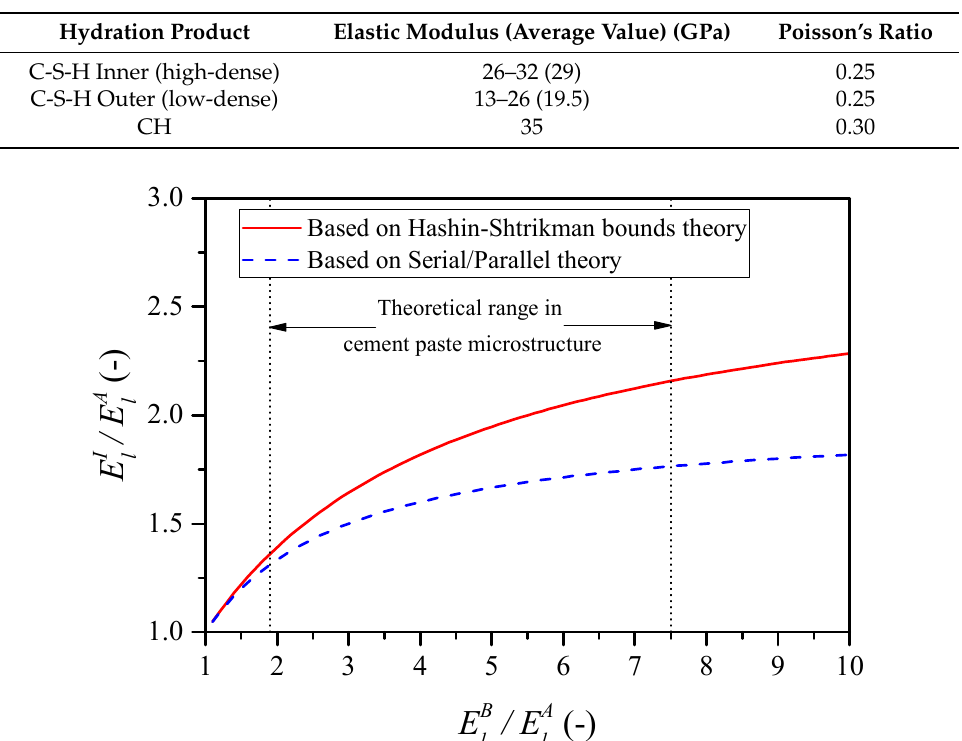
Table 4. The elastic properties of hydration products adopted in the modelling.